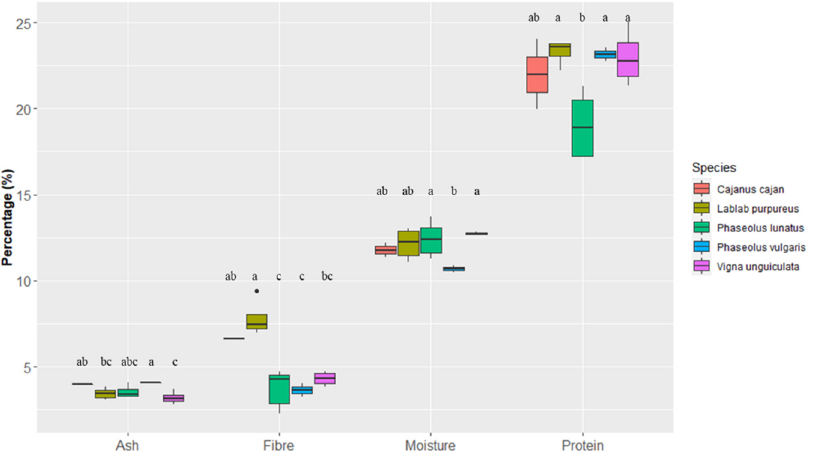
Figure 3. Intraspecific and interspecific variation of ash, fibre, moisture and protein contents in the beans of the five most cultivated and traded legume species of Cabo Verde. The box represents the 25th, 50th (median) and 75th percentiles, while whiskers represent the 10th and 90th percentiles with minimum and maximum observations. The black dots represent the outliers. Species sharing one or more letters for each trait are not statistically different ( p < 0.05). Table 2. Mean values, standard deviations and homogeneous groups 1 of the antioxidant capacities of the five most cultivated and traded legumes of Cabo Verde.